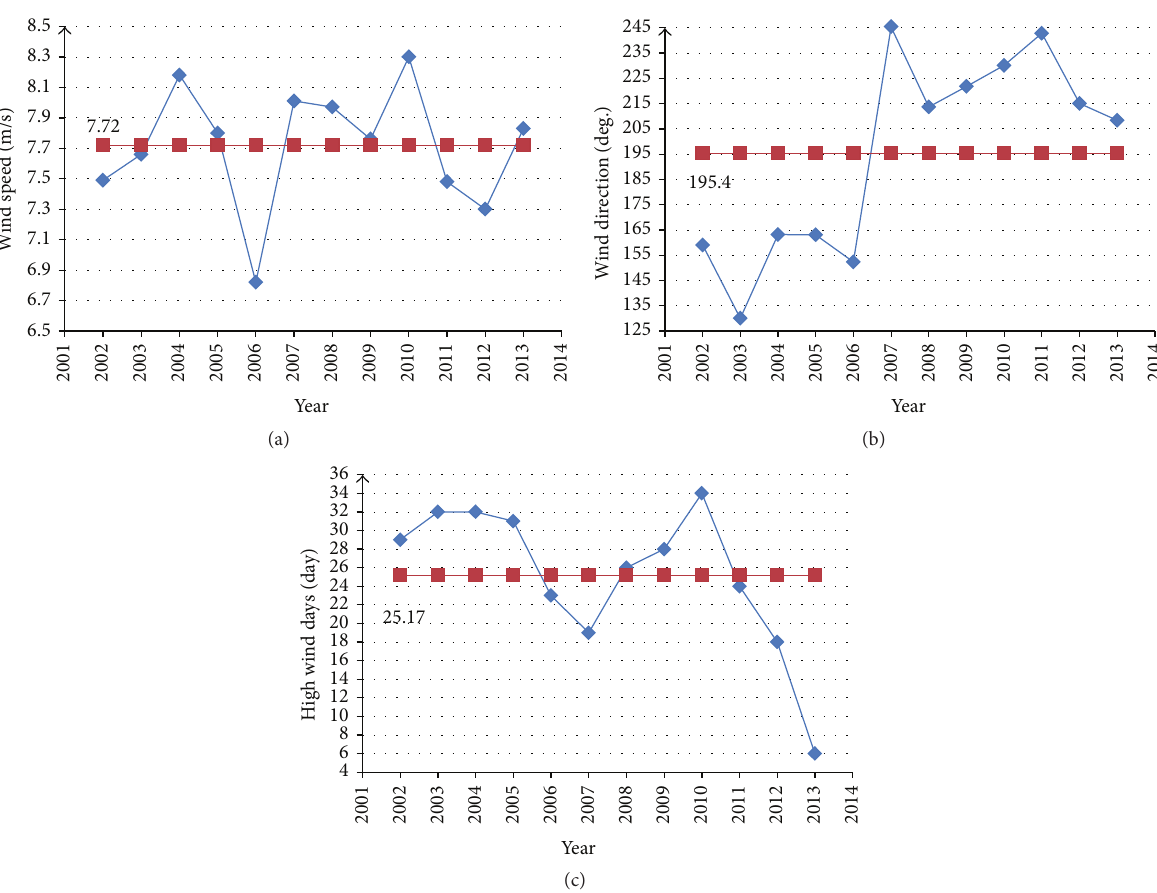
: wind direction; (c) high wind days. dir